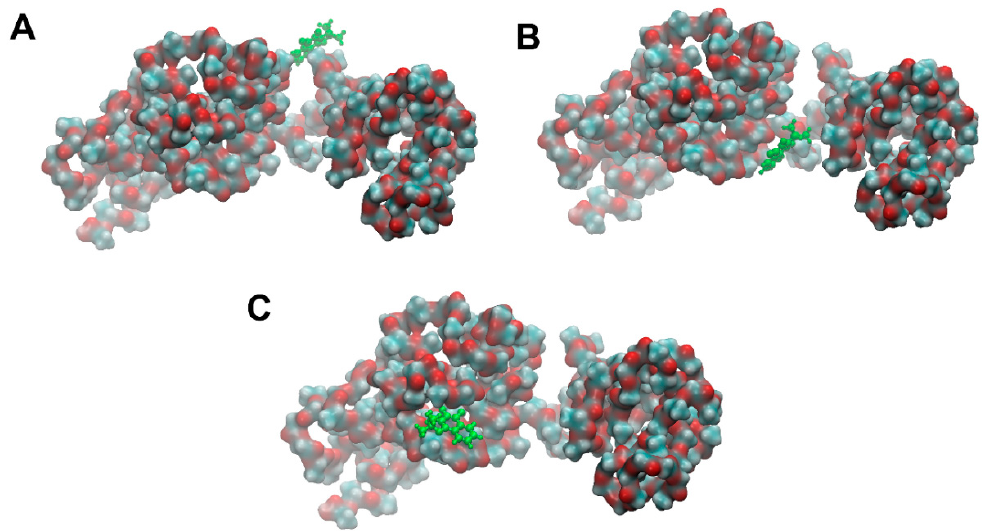
Figure 2. Characterization of the N β L-loaded PLGA microcapsules. ( A ) Size distribution of 500 microcapsules; ( B , C ) Respectively, infrared and Raman spectra of pure N β L (dotted line), empty PLGA microcapsules (dashed line) and N β L-loaded PLGA microcapsules (black line). The shading in the IR absorption spectrum highlights the wavenumber region depicted in the Raman plot. Raman band wavenumbers and their corresponding normal mode assignments are depicted as well.